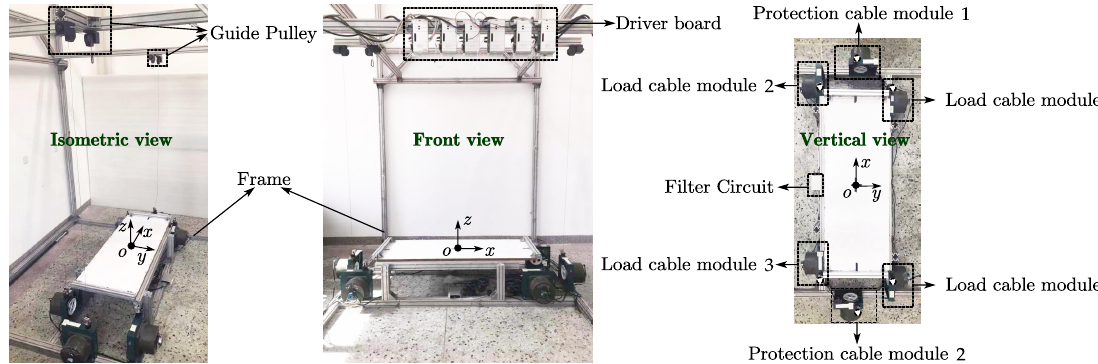
Figure 12. Prototype of